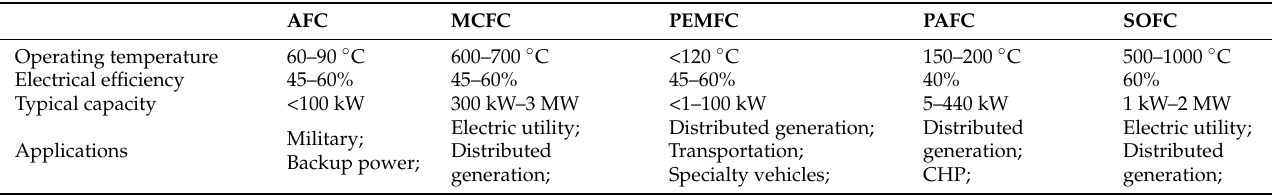
Table 1. Comparison of fuel cell